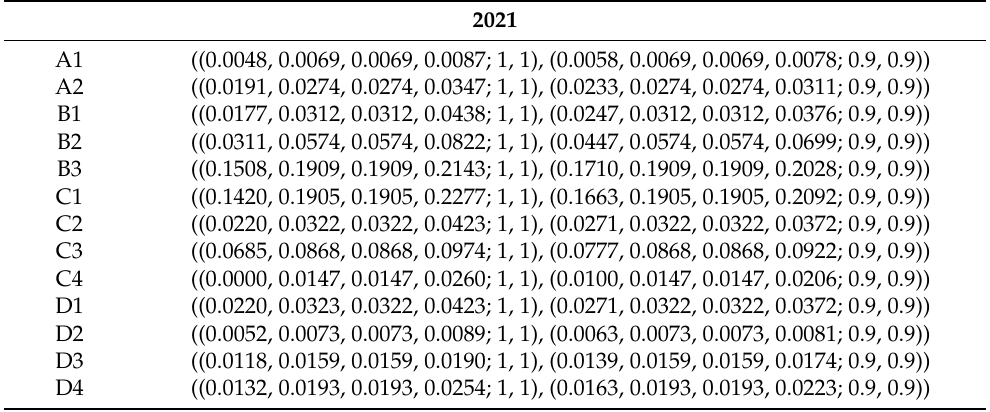
Table 18. Expert rating aggregation form